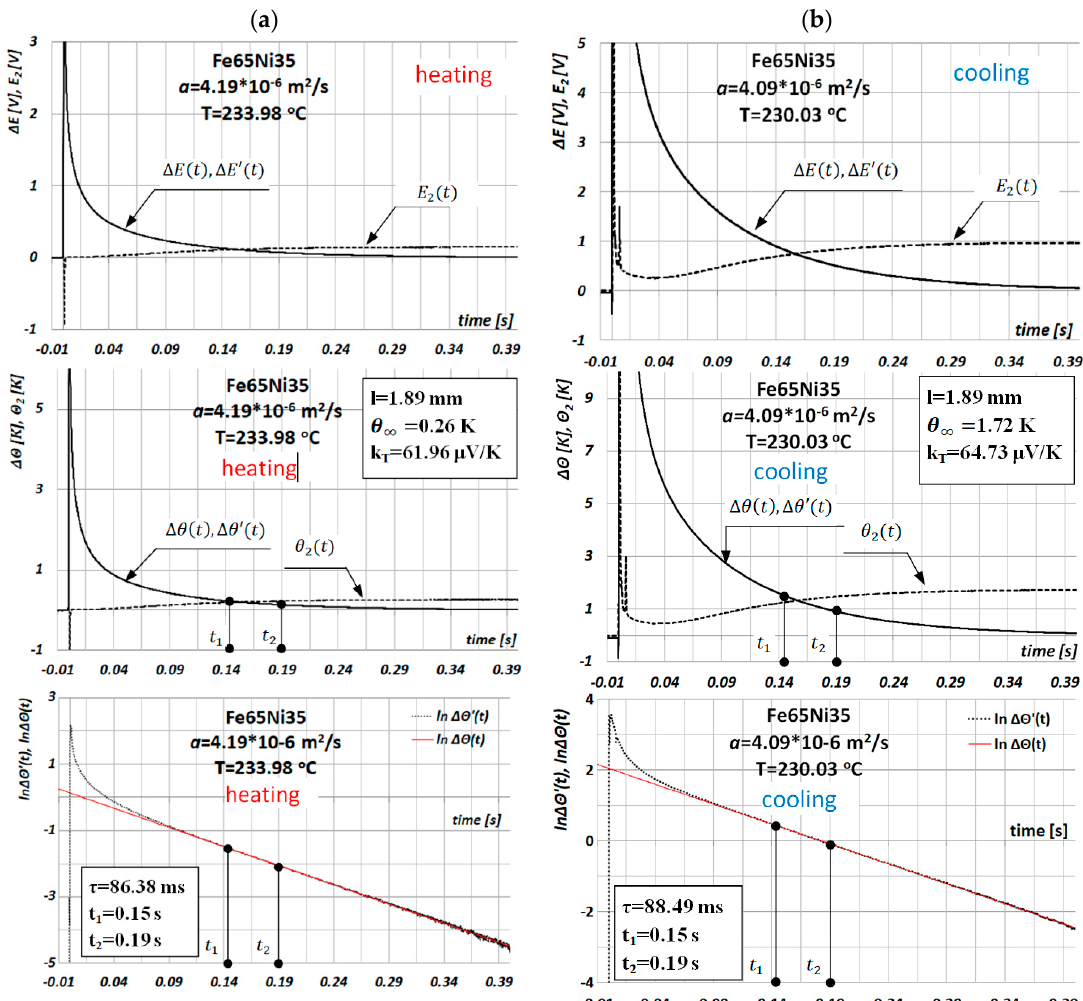
Figure 7. Exemplary results of discrete tests as a function of temperature of thermal-diffusivity values a ( T i ) of Fe65Ni35 alloy by the MPM ( a ) during heating T i = 233.98 °C and ( b ) during cooling T i = 230.03 °C.